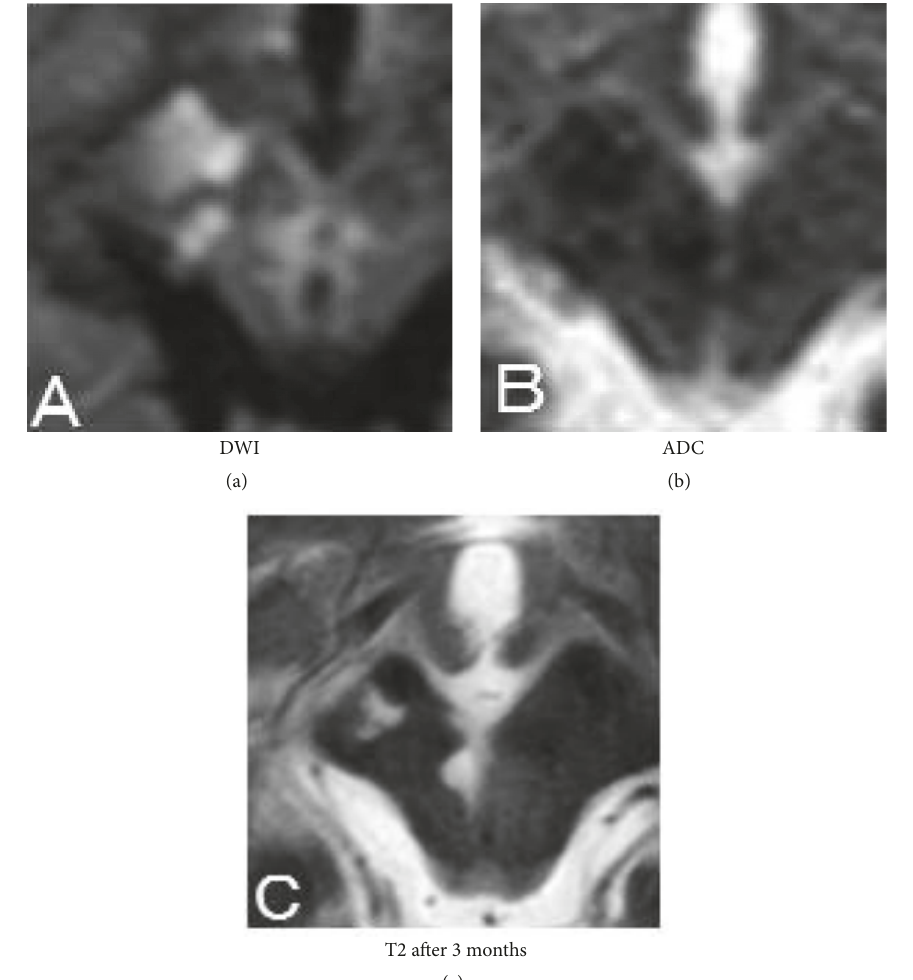
Figure 4: Head MRI on midbrain performed after aggravation of neurological symptoms. ADC map indicates the left paramedian lesion as stroke (a, b). Bilateral paramedian lesions three months after onset